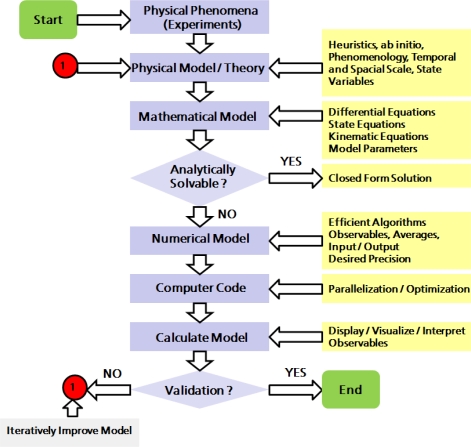
Physical, mathematical and numerical modeling scheme illustrated as flow chart. Starting from the experimental evidence one constructs physical theories for which a mathematical formulation usually leads to differential equations, integral equations, or master (rate) equations for the dynamic (i.e., time dependent) development of certain state variables within the system’s abstract state space. Analytic solutions of these equations are very rarely possible, except when introducing simplifications usually involving symmetries. Thus, efficient algorithms for the treated problem have to be found and implemented as a computer program. Execution of the code yields approximate numerical solutions to the mathematical model which describes the dynamics of the physical “real” system. Comparison of the obtained numerical results with experimental data allows for a validation of the used model and subsequent iterative improvement of the model and of theory.